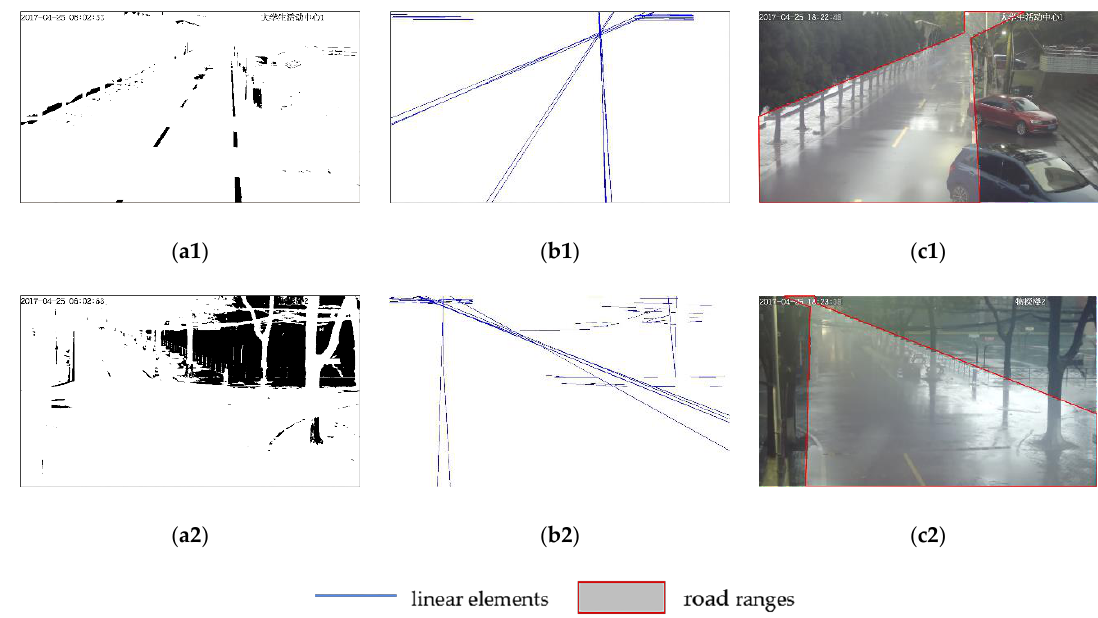
Figure 9. Road ranges extraction: Threshold segmentation ( a1 , a2 ), Linear elements ( b1 , b2 ) and Road ranges ( c1 , c2 ).